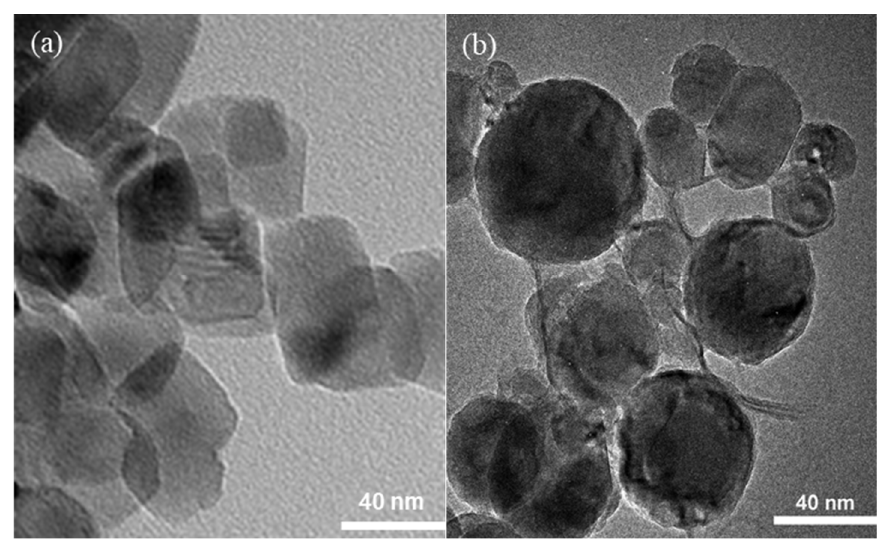
Figure 2. TEM images of ( a ) TiO 2 and ( b ) F-TiO 2 . The SEM and energy dispersive spectroscopy (EDS) of 0.1% Au/F-TiO 2 (Figure S3) show that there are F and Au elements on the surface of the catalyst. This also proved that the F − modification and Au loading on TiO 2 were successfully realized in the sample preparation. The element mapping of Au/F-TiO 2 (n F : n Ti = 2.5) in Figure 3 shows that both F and Au are evenly distributed on the surface of TiO 2 , which is consistent with the element types shown in the EDS result (Figure S3).